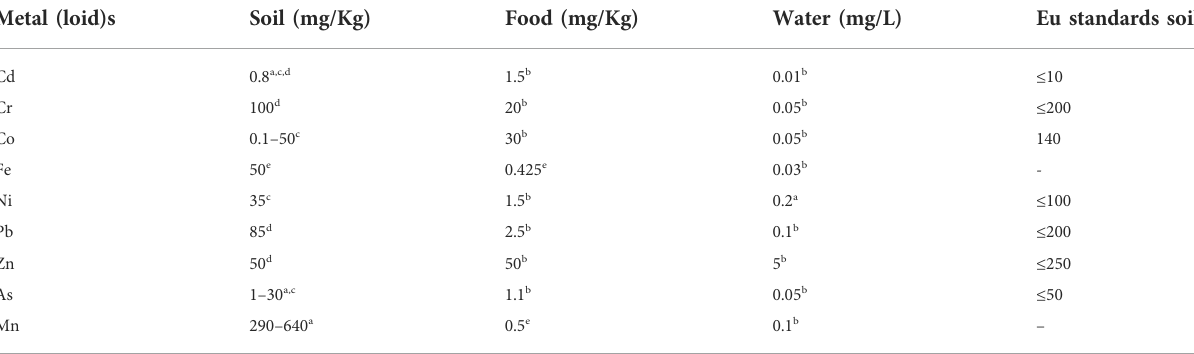
TABLE 1 Standards criteria for Maximum permissible limits for Metal(loid)s [Source: Kabata-Pendias and Pendias, (2011) a ; Liu et al. (2018) b ; WHO (1996) c ; Denneman and Robberse (1990) d ; Chiroma et al., (2014) e ]. Metal